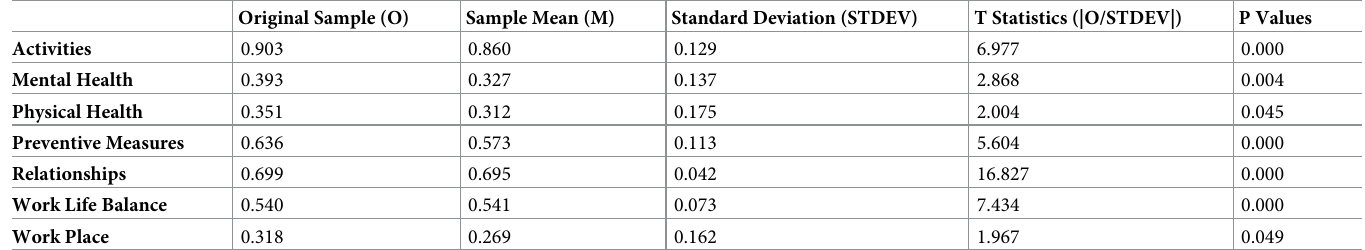
Table 5. Composite reliability measures of constructs, Bootstrapping with 2000 samples.